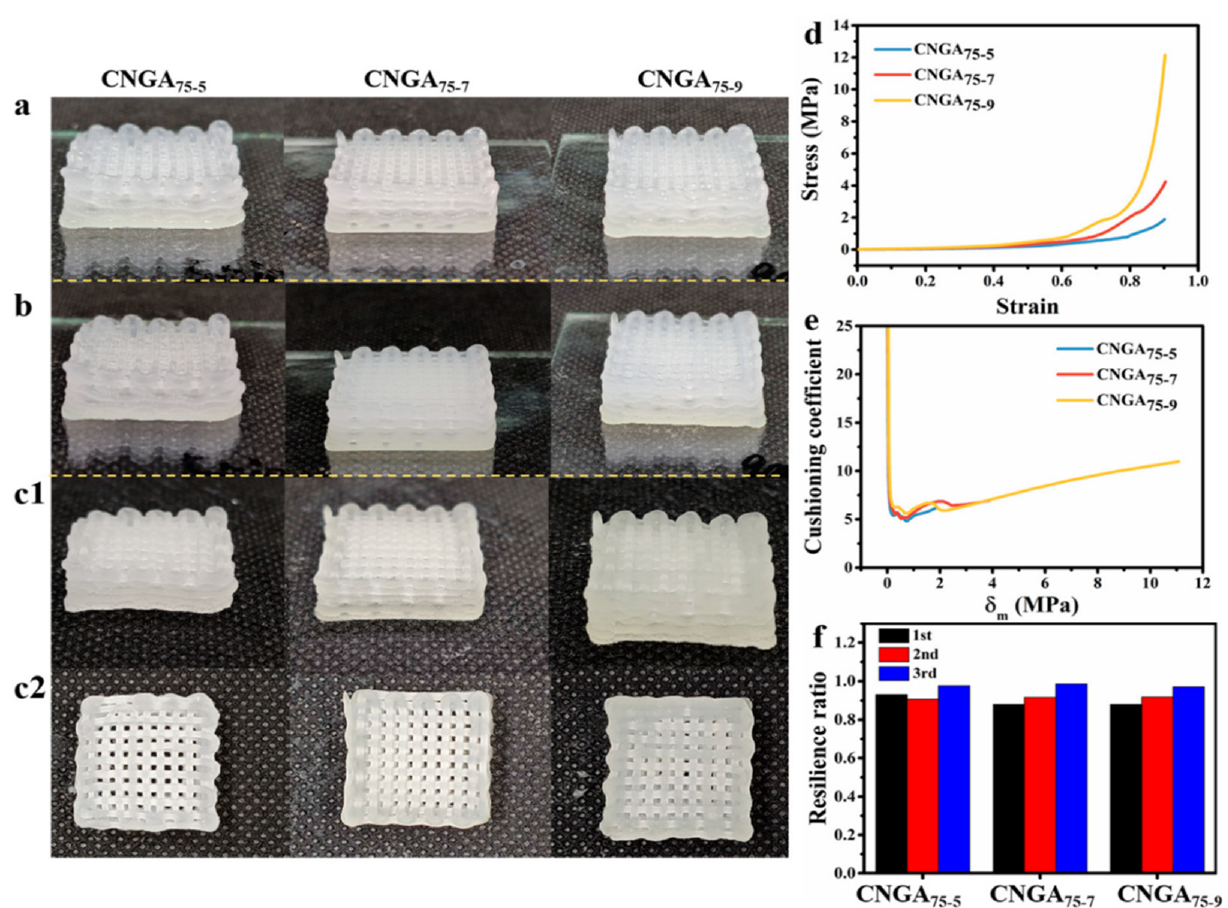
Figure 12. Morphology of 3D-printed samples by 75ink with different crosslinking times, before ( a ) and after ( b ) UV curing and after freeze-drying ( c1 , c2 ). ( d ) Stress-strain curves, ( e ) cushioning curves, and ( f ) thrice compression resilience ratio of samples with different crosslinking times, used with permission from ref. [50].